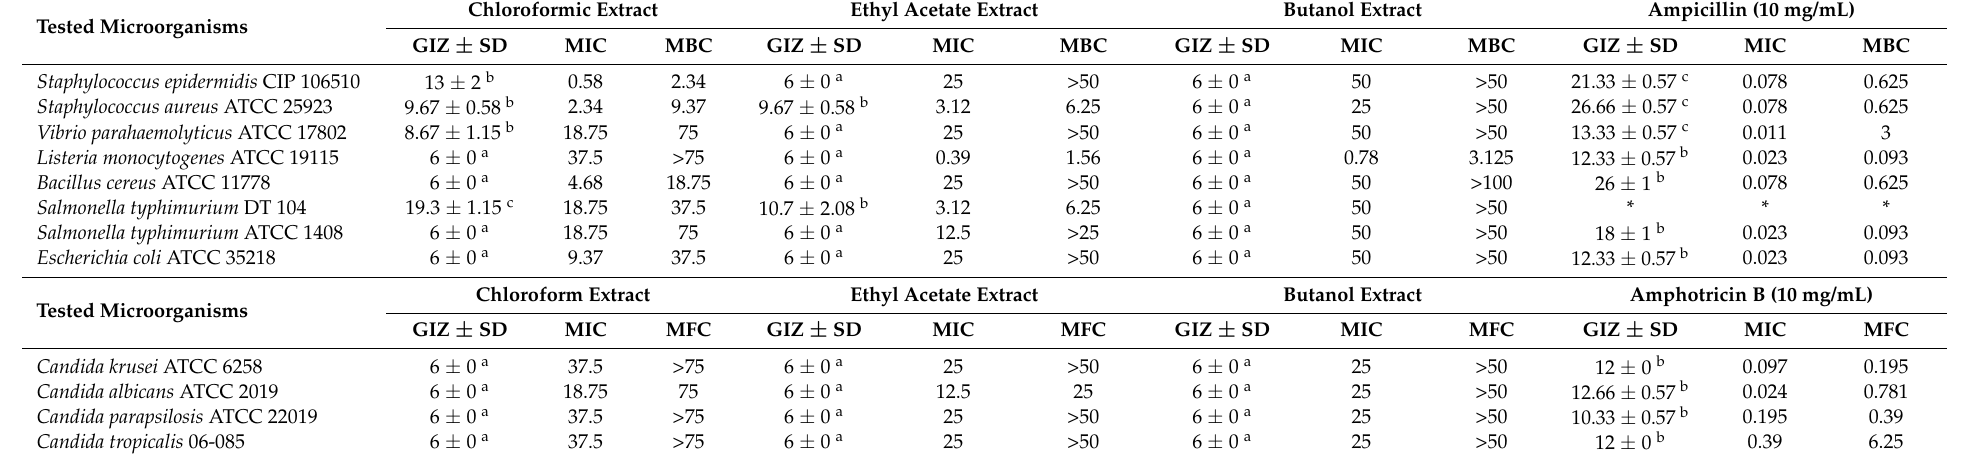
Table 3. Antibacterial and antifungal activities (expressed as diameter of IZ ± SD, on mm), MIC and MBC values (mg/mL) of A. tenuifolius organic extracts. Tested Microorganisms